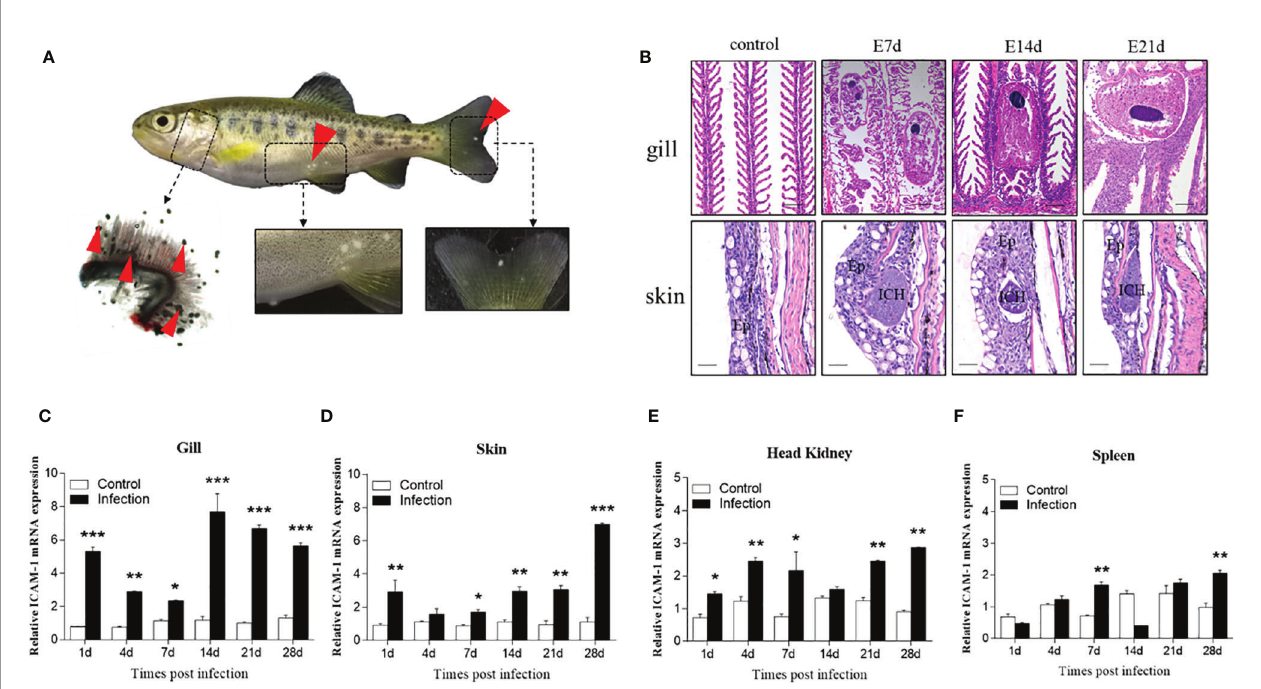
FIGURE 6 | Changes induced by I. multi fi liis infection. (A) The phenotype of an infected rainbow trout. Red arrowheads point to Ich trophonts. Details were shown in the gills, skin, and fi n. (B) Hematoxylin/eosin staining of gills and skin from infected fi sh at different days. Ep, epidermis; ICH, I. multi fi liis . Scale bar, 40 m m. (C – F) The ICAM-1 mRNA expression level of the gills (C) , skin (D) , head kidney (E) , and spleen (F) at 1, 4, 7, 14, 21, and 28 days from infected and control trout (n = 6 per group). Data are expressed as mean fold increase in expression. Statistical analysis was performed by unpaired Student ’ s t test. *P < 0.05, **P < 0.01, ***P < 0.001. Data are representative of three different independent experiments (mean ±